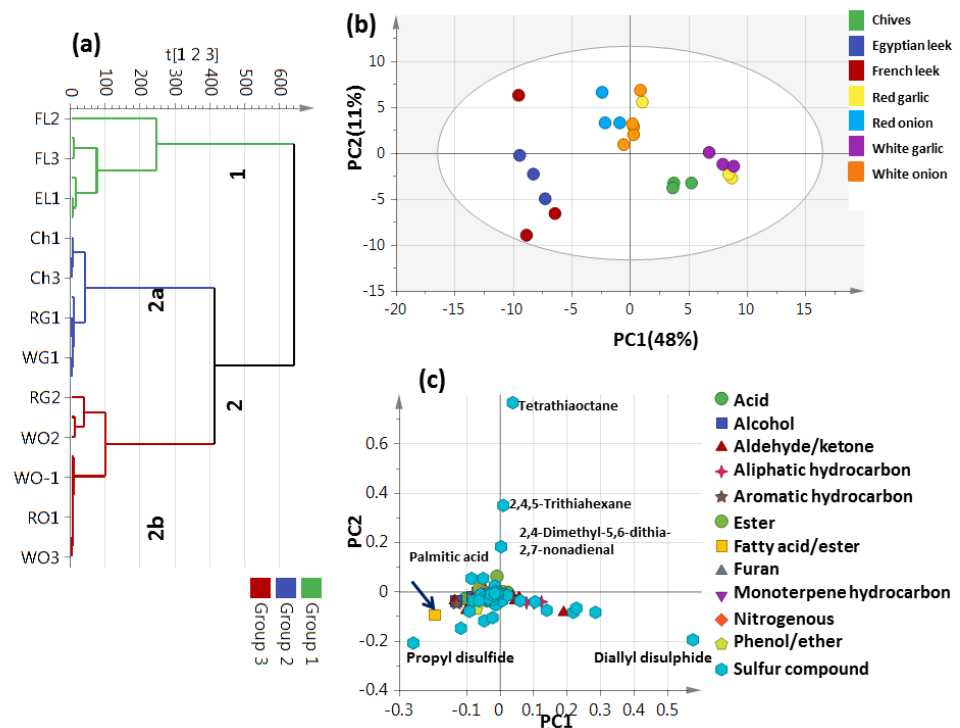
Figure 4. Unsupervised multivariate data analyses of the studied Allium species derived from modeling volatile metabolites dataset analyzed using SPME GC-MS (n = 3). ( a ) HCA plot. ( b ) PCA score plot of PC1 vs. PC2. ( c ) Loading plot for PC1 and PC2, providing variant peaks and their assignments. The metabolome clusters are placed in two-dimensional space at the distinct locations defined by PC1 = 48% and PC2 = 11%.